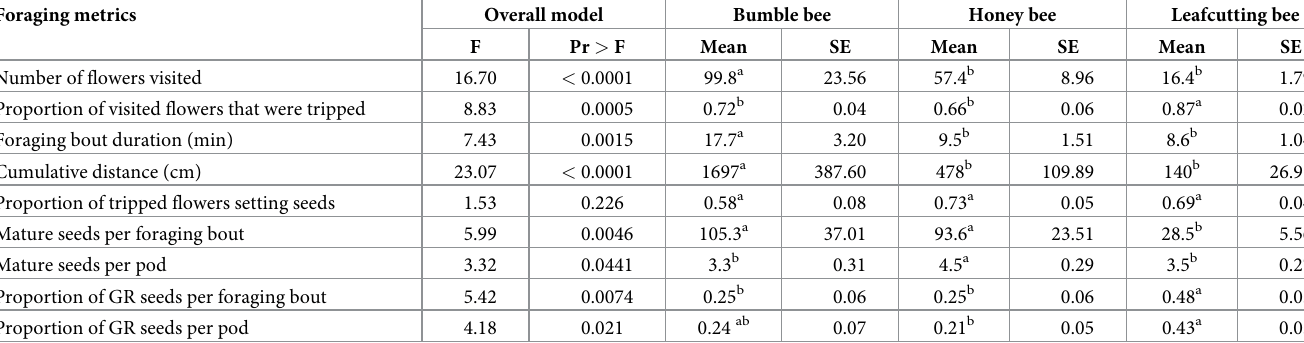
Table 3. Differences in foraging metrics (per foraging bout) among bee species with respective means and standard errors. Foraging metrics Number of flowers